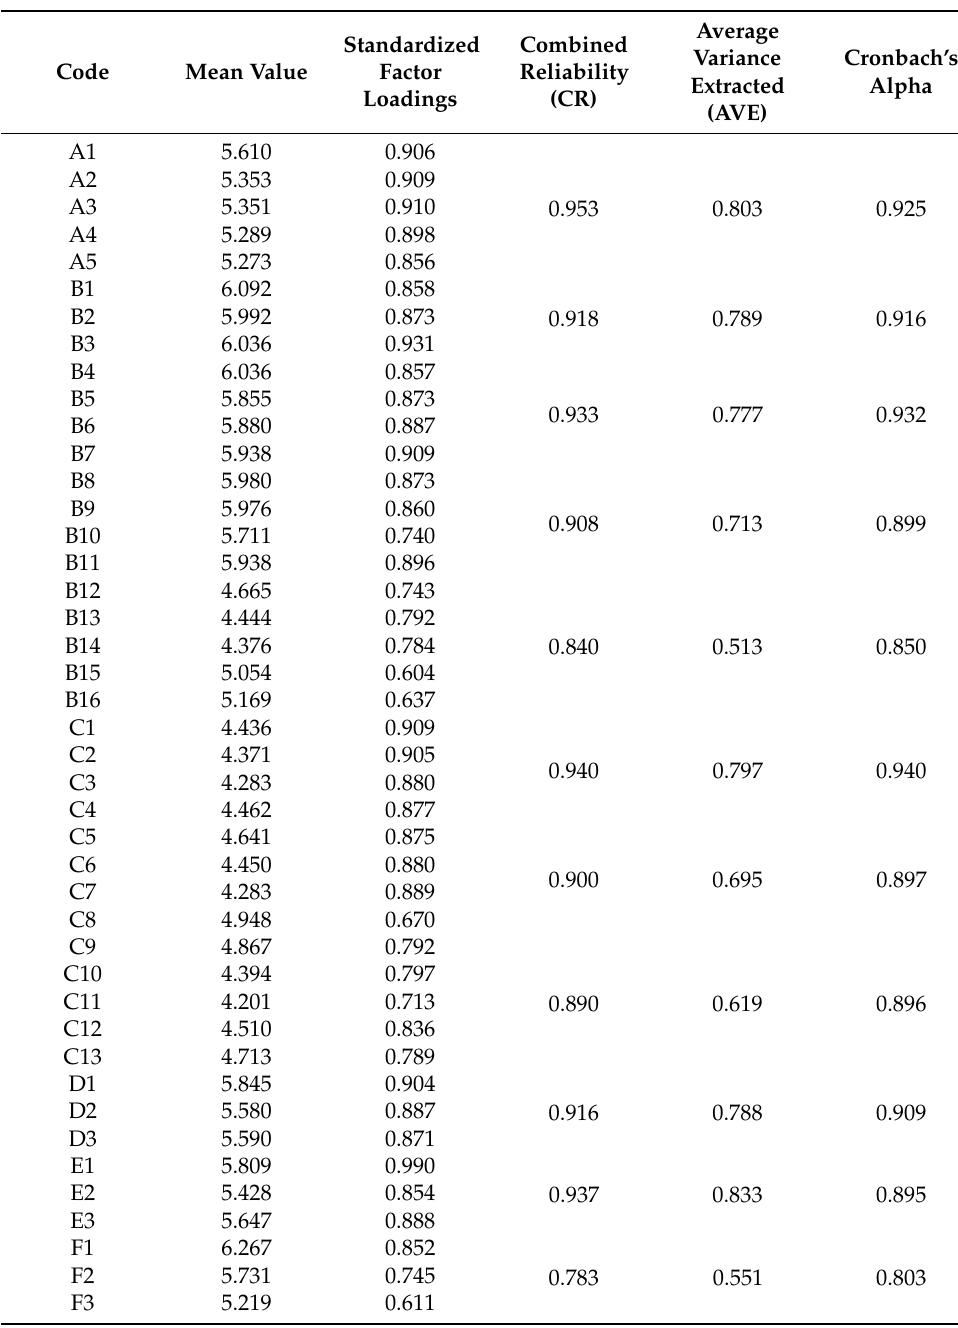
Table 3. Descriptive statistics and reliability